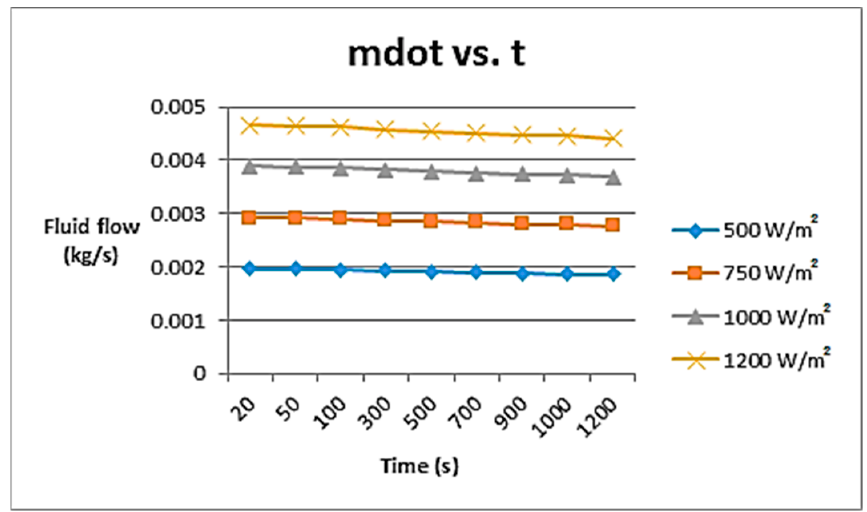
Figure 3. Water mass flow rate at different solar radiations and heat exchanger temperature difference of 15 °C.